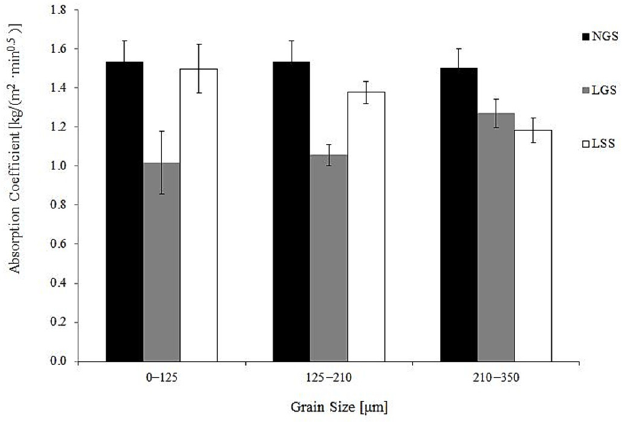
Figure 11. Water absorption coefficient results.